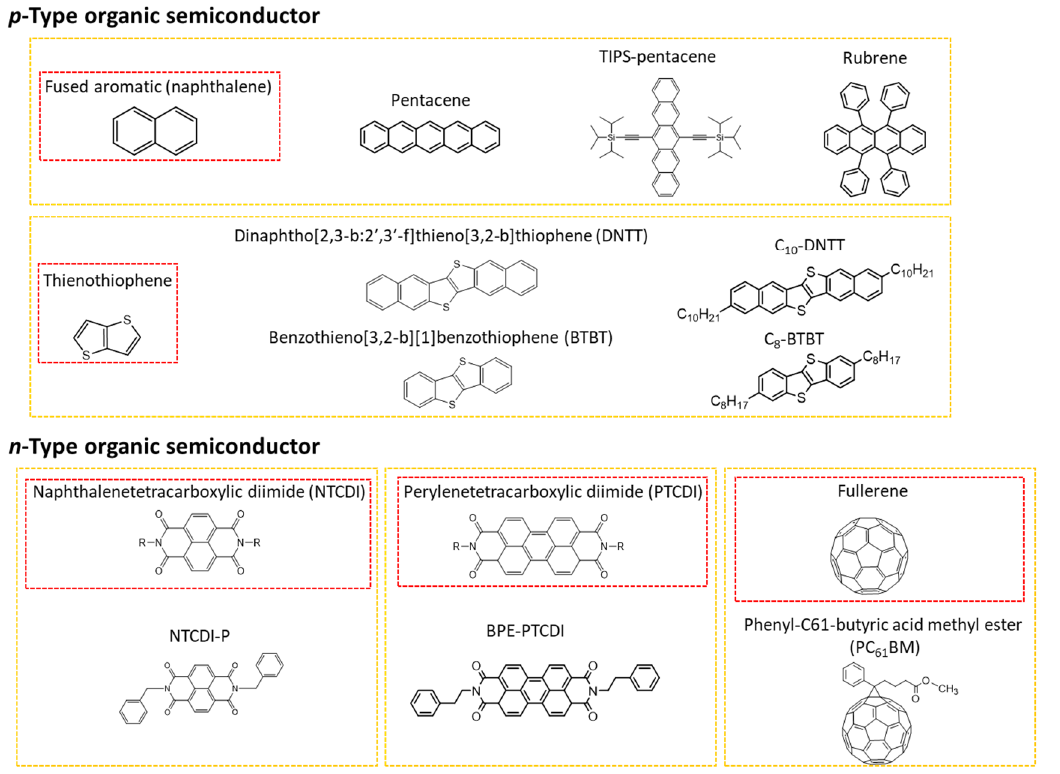
Figure 2. Organic semiconductors (small molecule-based) with respect to polarity ( p - and n -type) in biomedical applications. A molecule in red box is a unit molecule in yellow box.